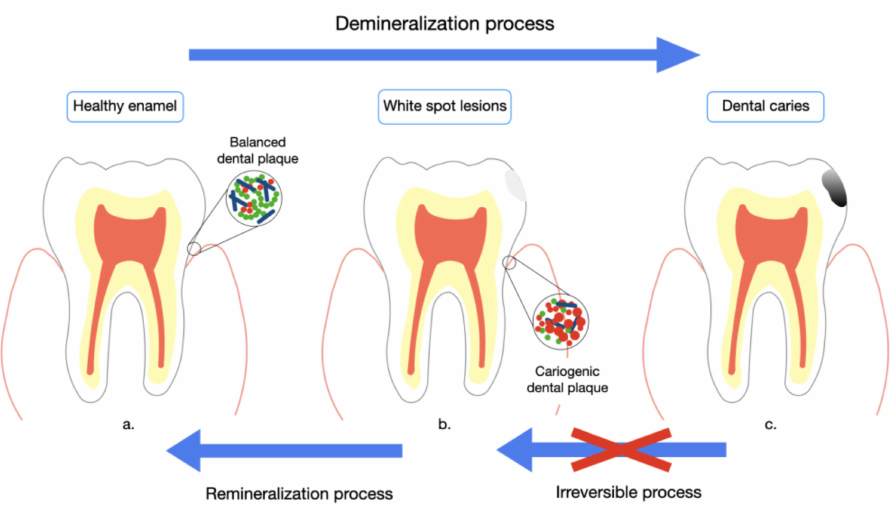
Figure 2. Demineralization and remineralization processes. ( a ) Enamel is healthy with balanced bacterial plaque. ( b ) The plaque changes and becomes cariogenic and starts the formation of a WSL (reversible lesion). ( c ) If the WSL is left untreated and the bacterial plaque is not removed, an irreversible carious process begins (cavitated